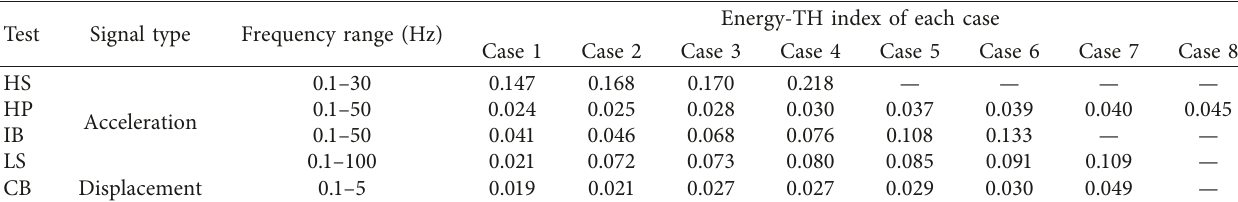
Figure 33. The correlation coefficient is expressed by the correlation coefficient, which equals to 1 − c .